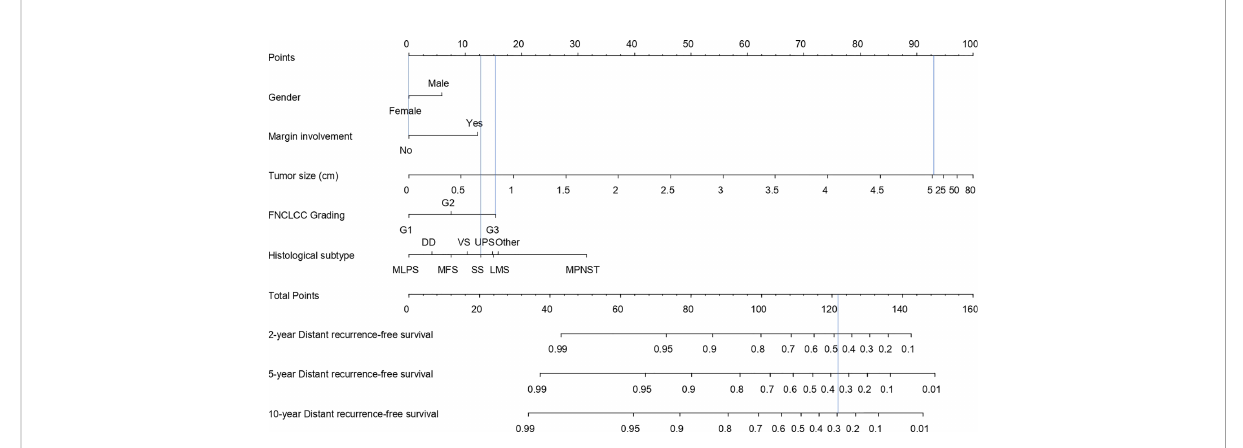
FIGURE 5 Nomogram for calculation of 5- and 10-year distant recurrence-free survival